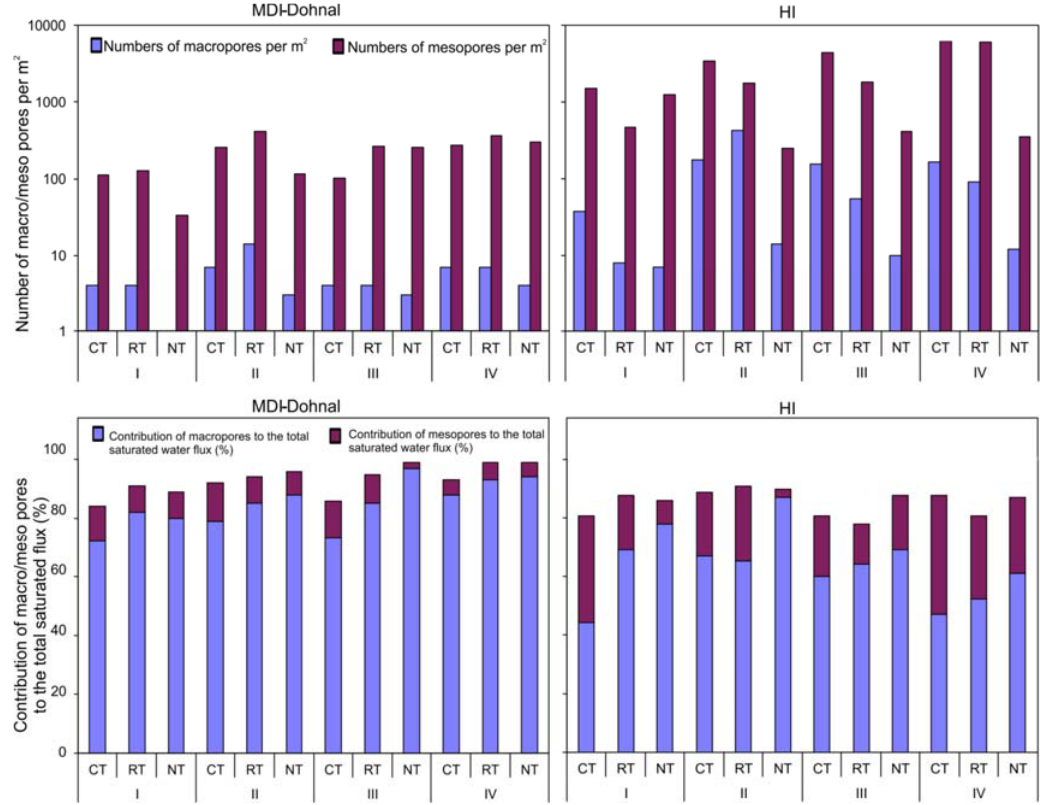
Figure 8. Upper pair of graphs describes number of macro/meso pores per 1 m 2 determined from MDI-Dohnal and HI data for each soil treatment (CT, RT, NT) and for each experimental phase (I-IV), lower pair of graphs describes contribution of the macro/meso pores to the total saturated flux in % with respect to the infiltrometer type, soil treatment and experimental phase.